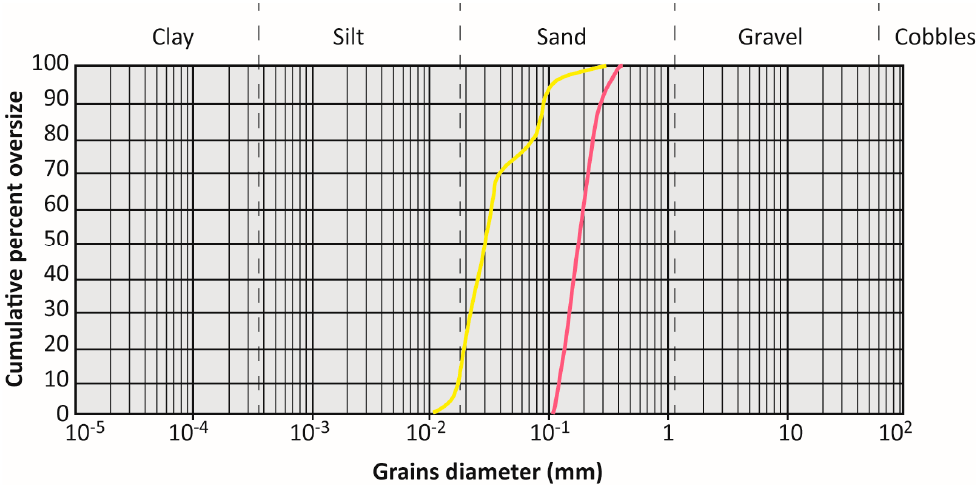
Figure 2. Grain-size distribution curve for the pure Q-sand ( red line ) and the pure K-feldspar sand ( yellow line ).